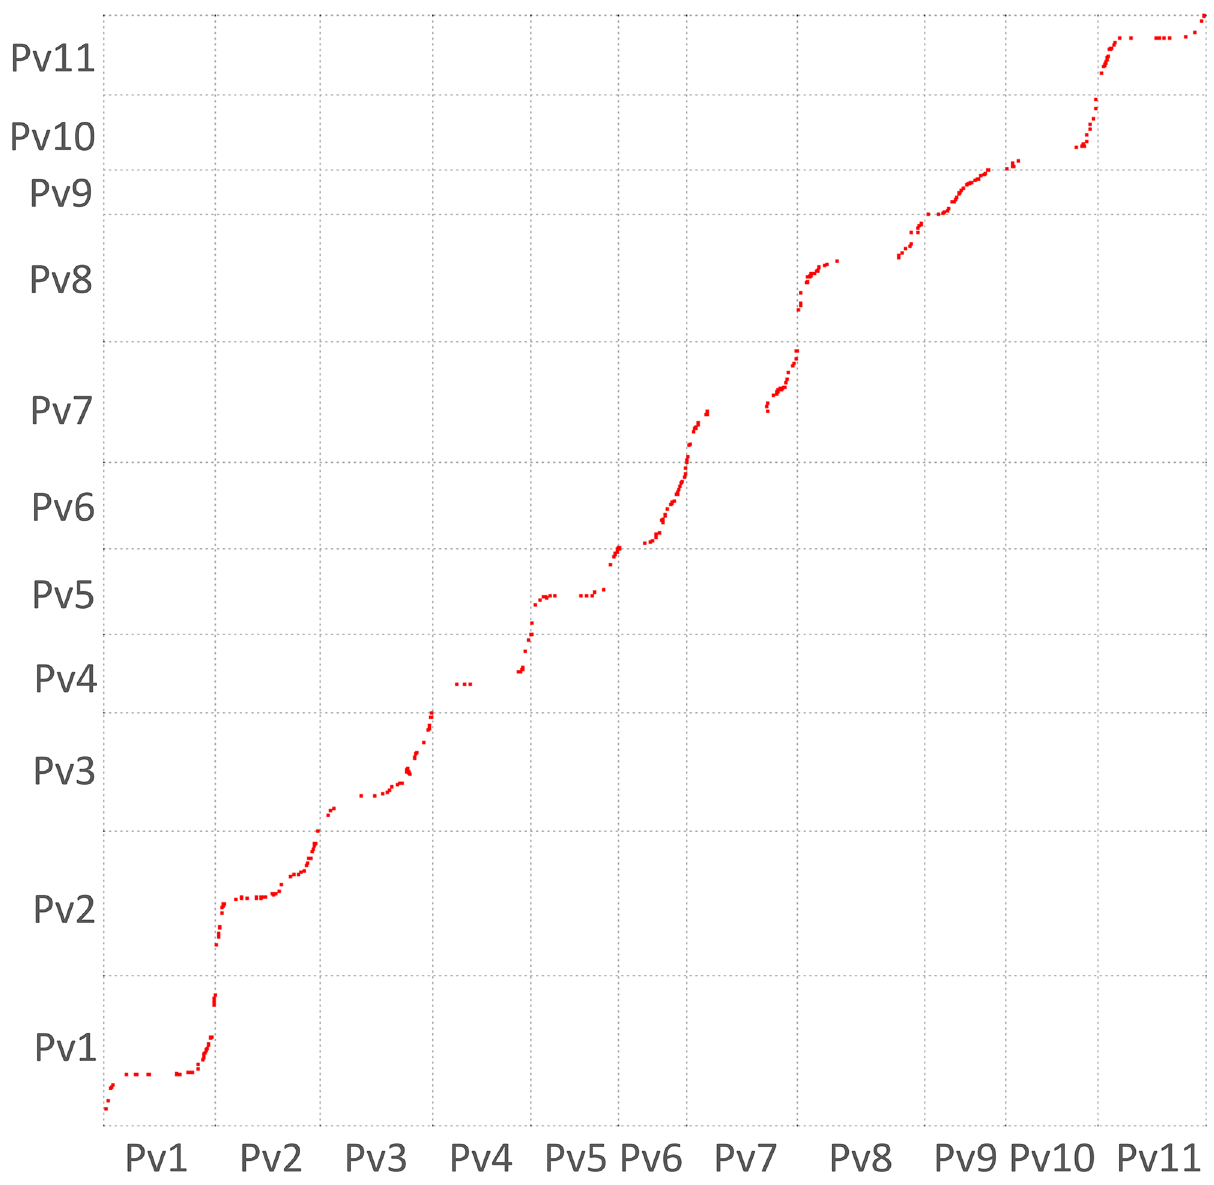
Fig 3. SNP marker amplicon similarity hits in the common bean genome from physical chromosome position (y-axis) to genetic position to (x- axis) with all chromosomes placed end-to-end and oriented per sequence information.